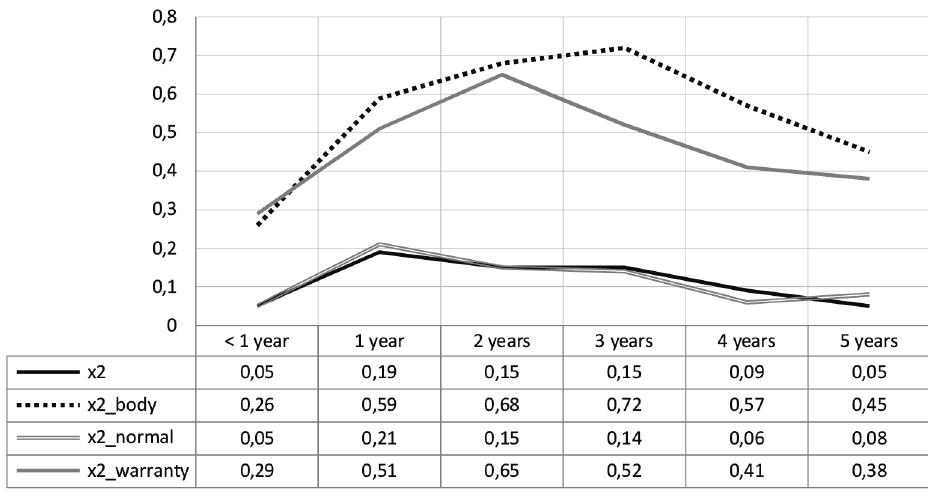
Source: own elaboration of the research conducted in